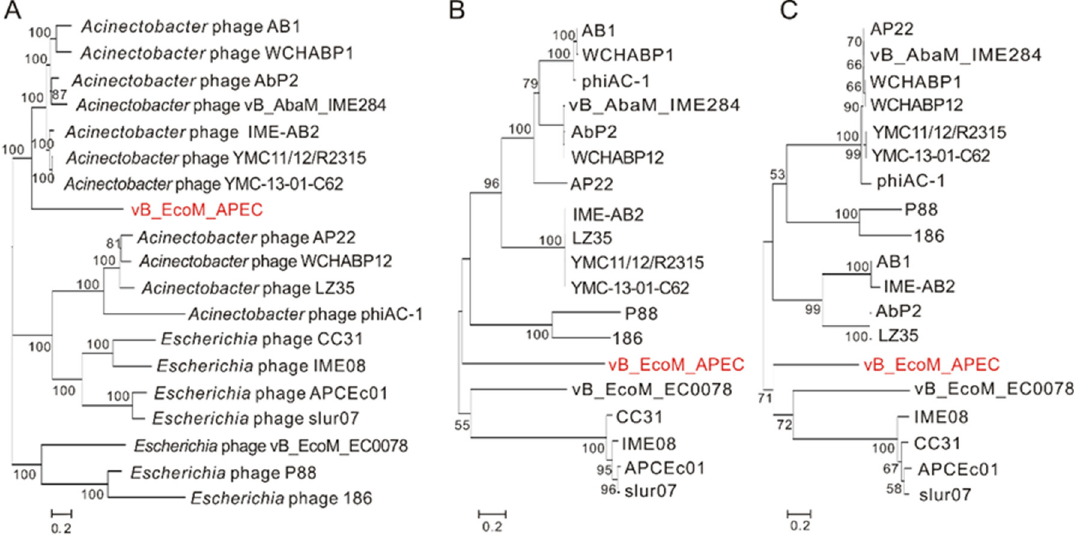
Figure 3. Phylogenetic relationship of phage vB_EcoM_APEC with other phages that infect members of the genera Acinetobacter and Escherichia . Neighbor-joining trees were constructed on the basis of complete genome sequences and amino acid sequences using MEGA X with 1000 bootstrap replicates. ( A ) Phylogenetic tree based on the whole-genome sequences; ( B ) phylogenetic tree based on the amino acid sequences of major capsid proteins; ( C ) phylogenetic tree based on the amino acid sequences of the terminase large subunits.